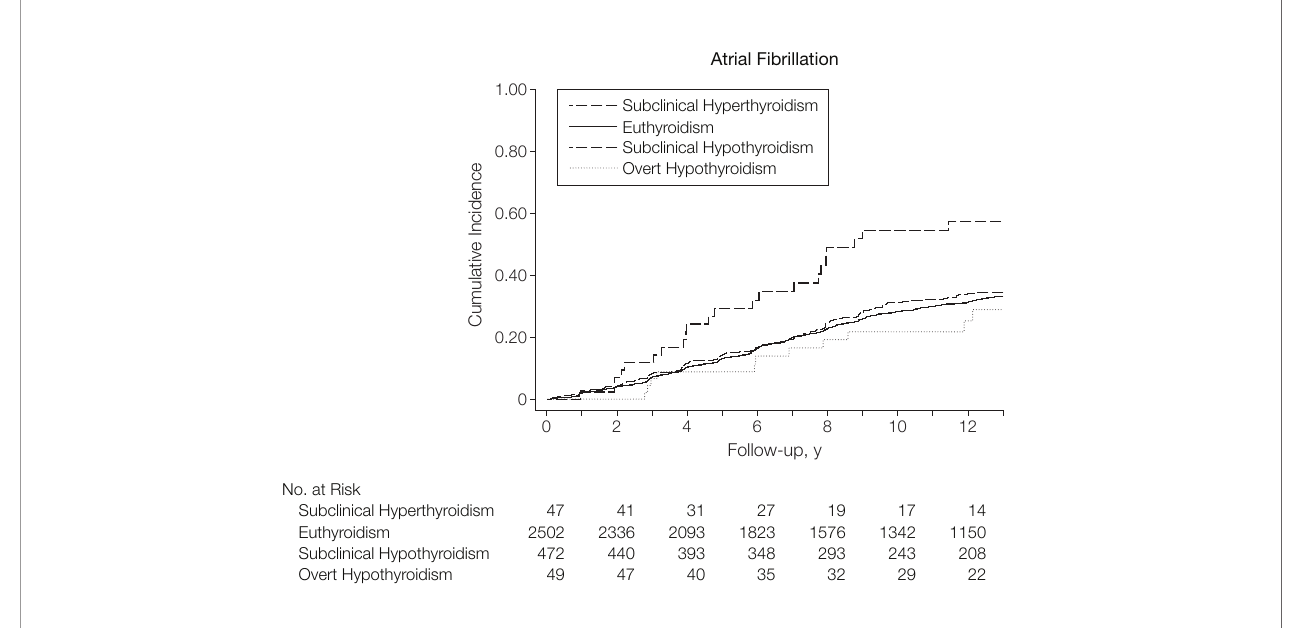
FIGURE 1 | Cumulative incidence of atrial fi brillation according to the thyroid function tests, de fi ned as: subclinical hyperthyroidism TSH 0.10 to 0.44 mIU/L and normal free T4; euthyroidism TSH 0.45 to 4.50 mIU/L; subclinical hypothyroidism TSH > 4.50 and < 20.0 mIU/L, and normal free T4. The 2 individuals with TSH < 0.10 mIU/L were not represented due to the small group size, adapted from Cappola et al. (26) ( with permission to reproduce